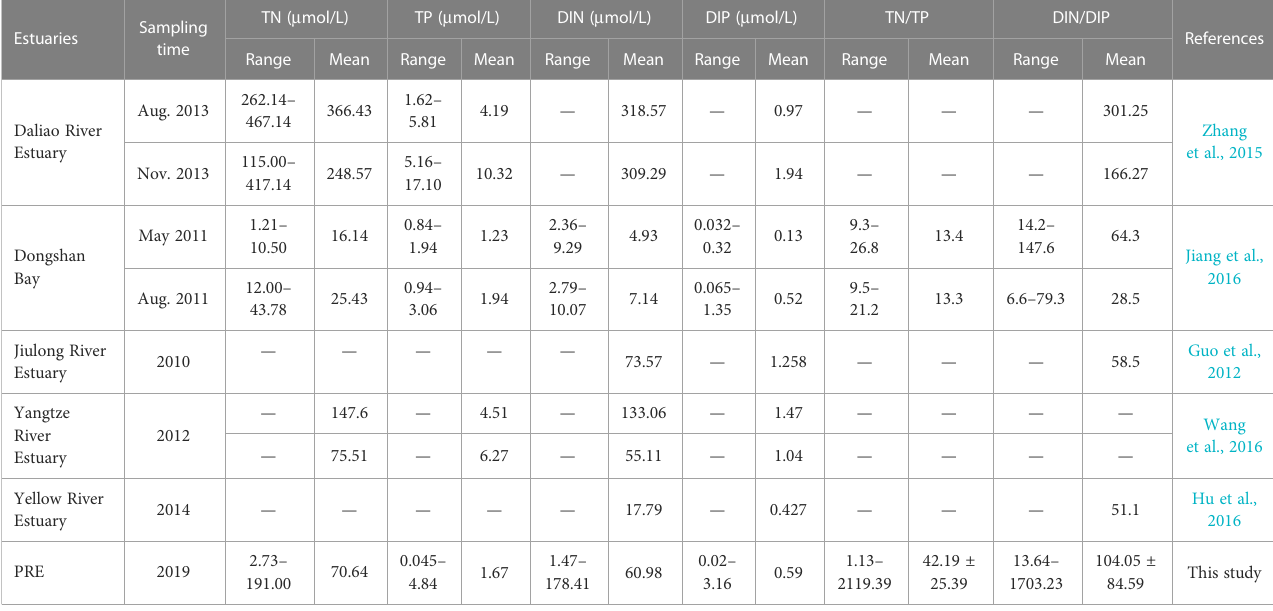
TABLE 2 Comparison of nutrient concentrations, TN/TP, and DIN/DIP in the PRE with other estuaries and bays of China.